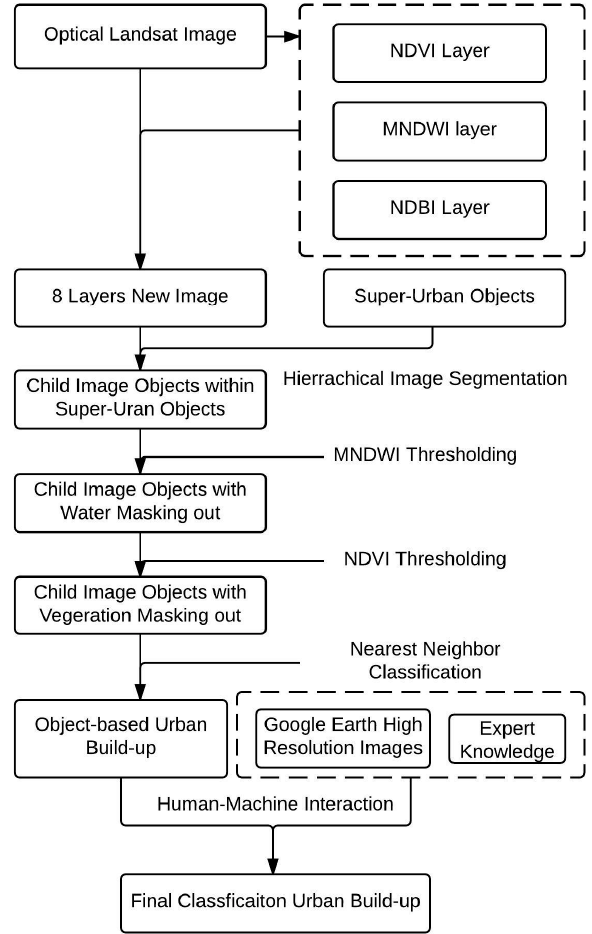
Figure 4. Flowchart for urban built-up classification that integrates the object-based classification and the knowledge-based manual corrections. NDVI is the normalized difference vegetation index; MNDWI is the modified normalized difference water index; and NDBI is the normalized difference built-up index.